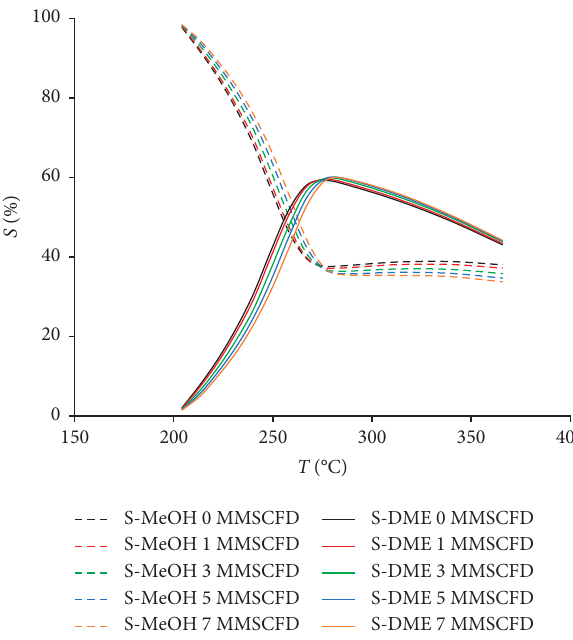
Figure 7: Effects of reactor temperature, T , at a pressure of 40 bar in the indirect and the direct processes on the CO 2 conversion, X , at various unreacted gas recycle rates. CO 2